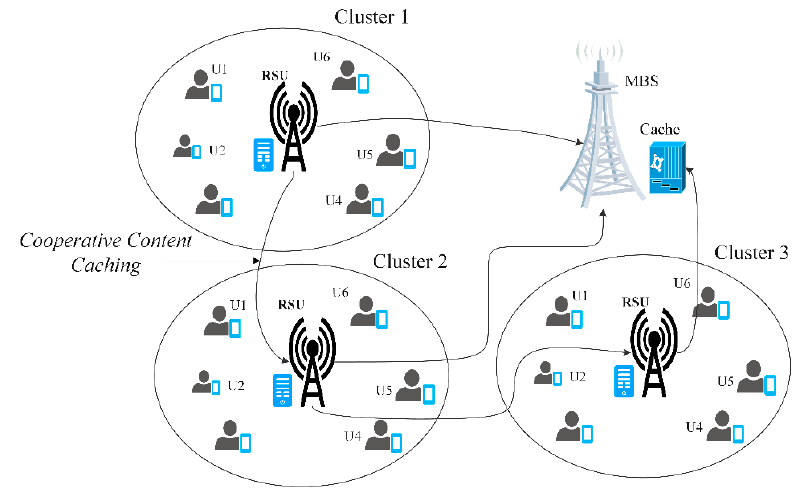
Figure 3 . Cooperative content caching (COOP) .